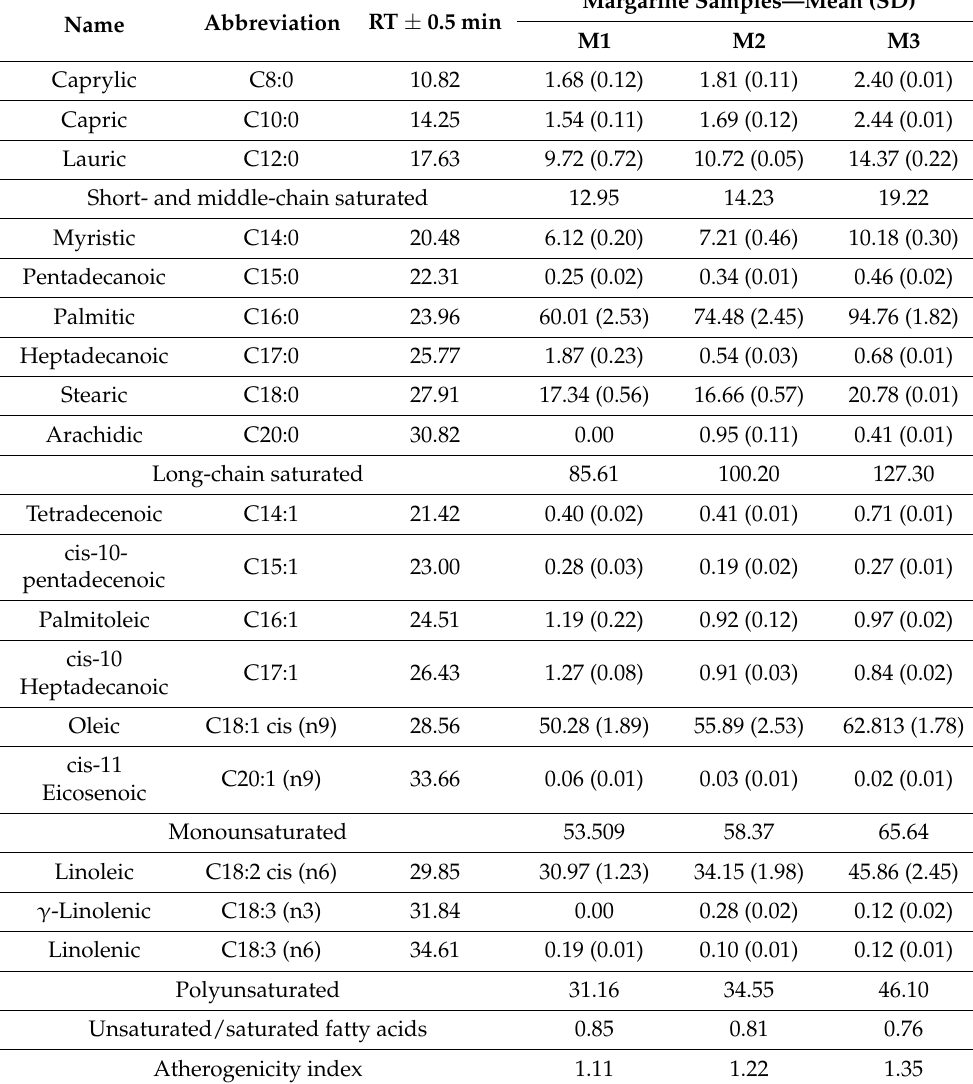
Table 3. Fatty acids concentration ( µ g/mg) of margarine